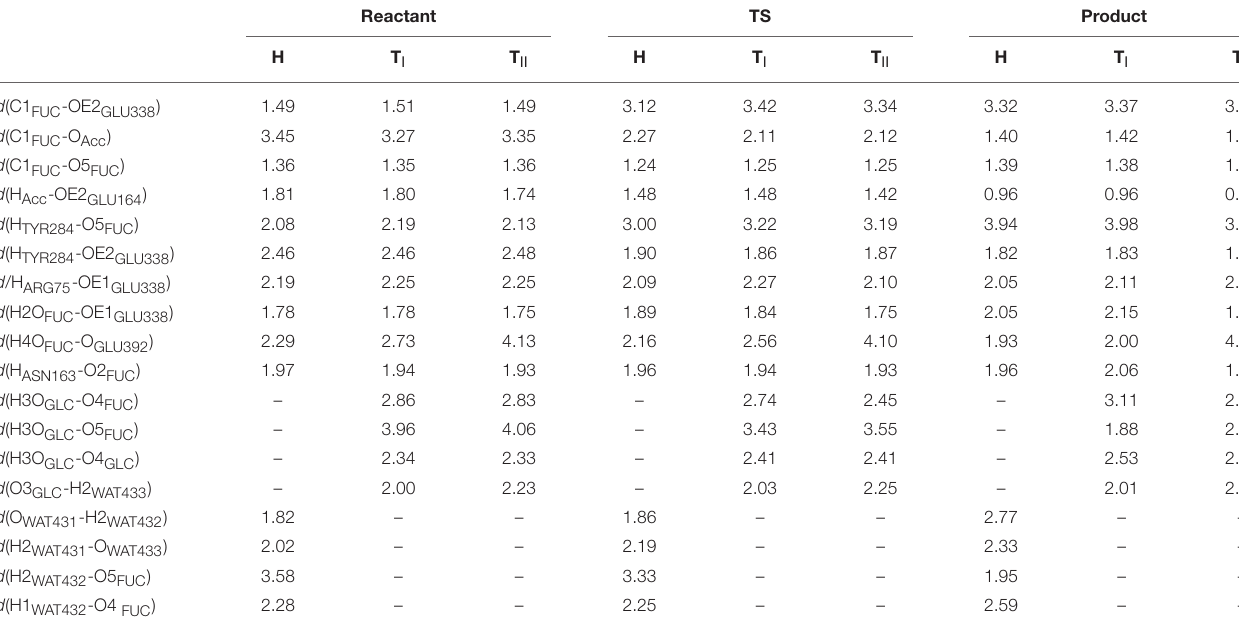
TABLE 4 | Distances (in Å) between selected atoms involved in each reaction step for the reactant, transition state (TS) and product of the hydrolysis (H) and transglycosylation (T I and T II , corresponding to the two different frames studied)